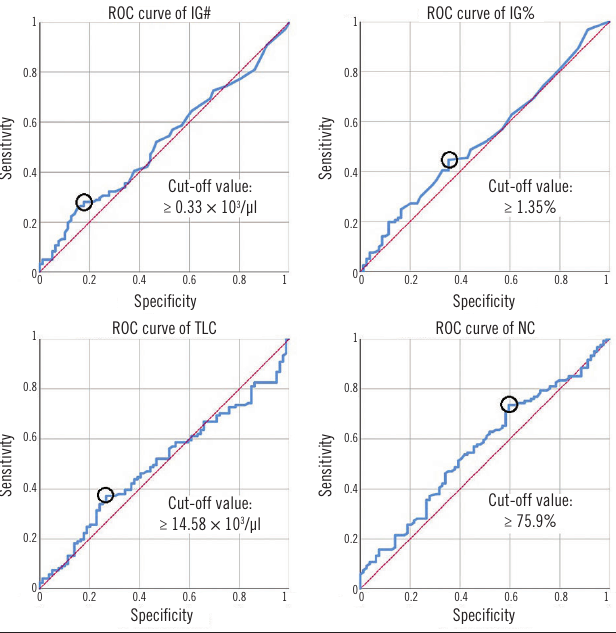
figurE 1 − ROC curve and cut-off values for IG#, IG%, TLC, and NC ROC: receiver operating characteristic; IG#: absolute automated count of immature granulocytes; IG%: relative automated count of immature granulocytes; TLC: total leukocyte count; NC: neutrophil